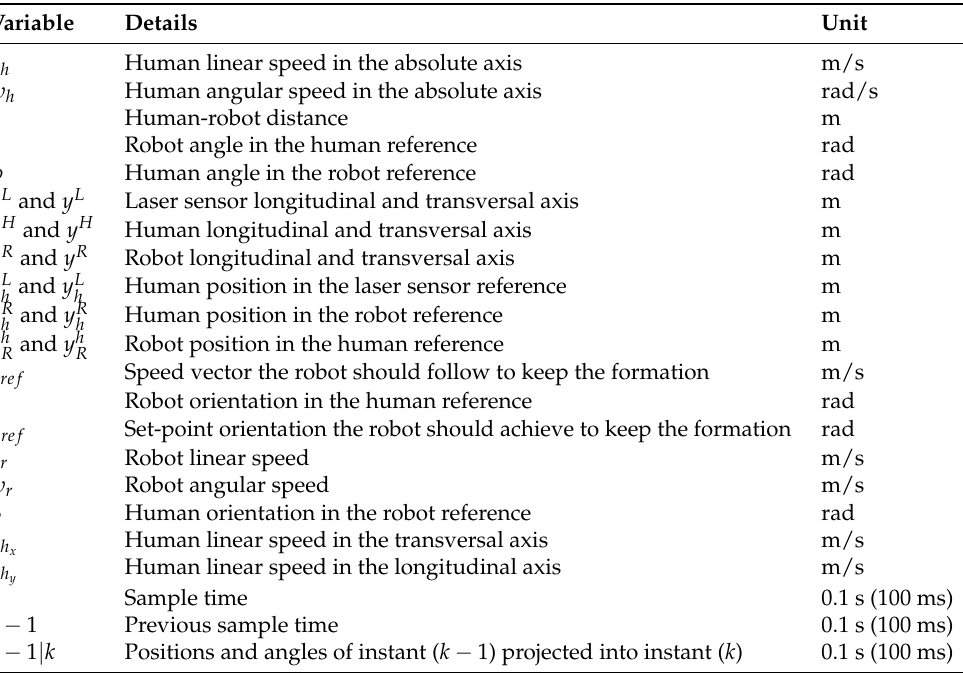
Figure 9. Diagram showing the human-robot interaction and the human, robot, laser sensor and absolute references. Table 2. Variables in Figure